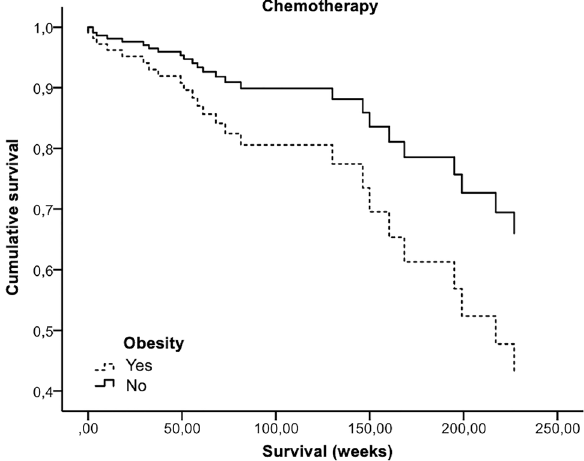
Image 6. Survival curve, in the Kaplan-Meier evaluation, relating obesity, according to the age groups of the patients, among patients undergoing chemotherapy Cox regression test, obesity: p=0.863; age group: p=